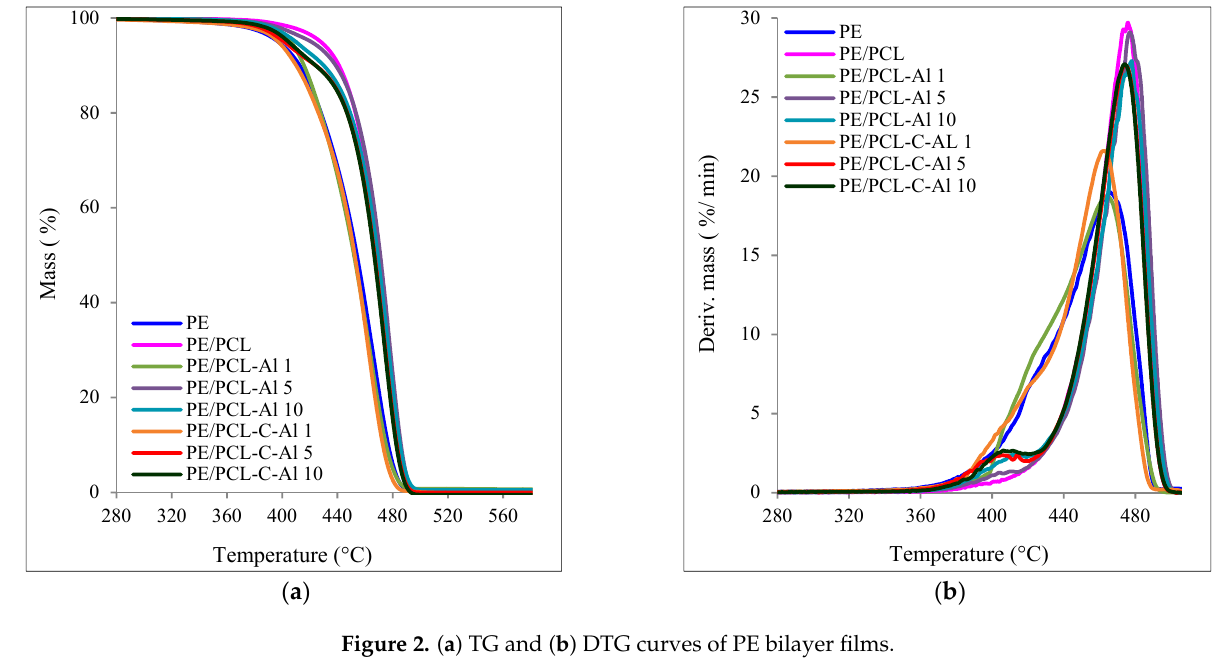
Figure 2. ( a ) TG and ( b ) DTG curves of PE bilayer films.